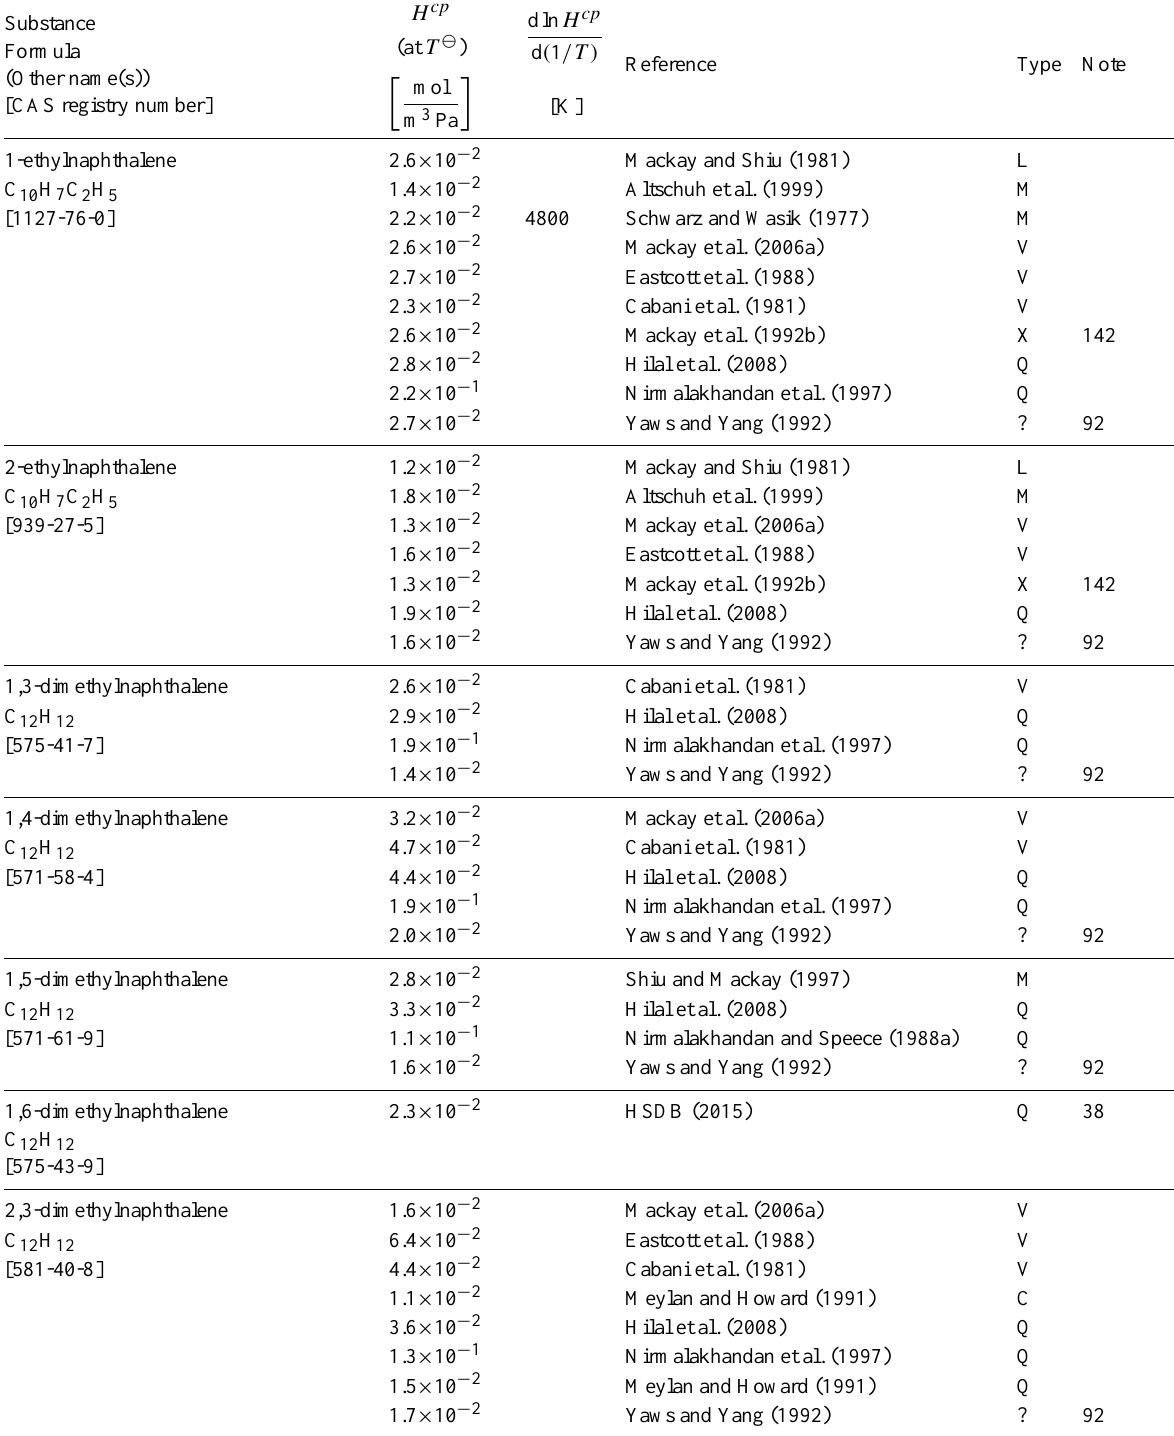
Table 6: Henry’s law constants for water as solvent